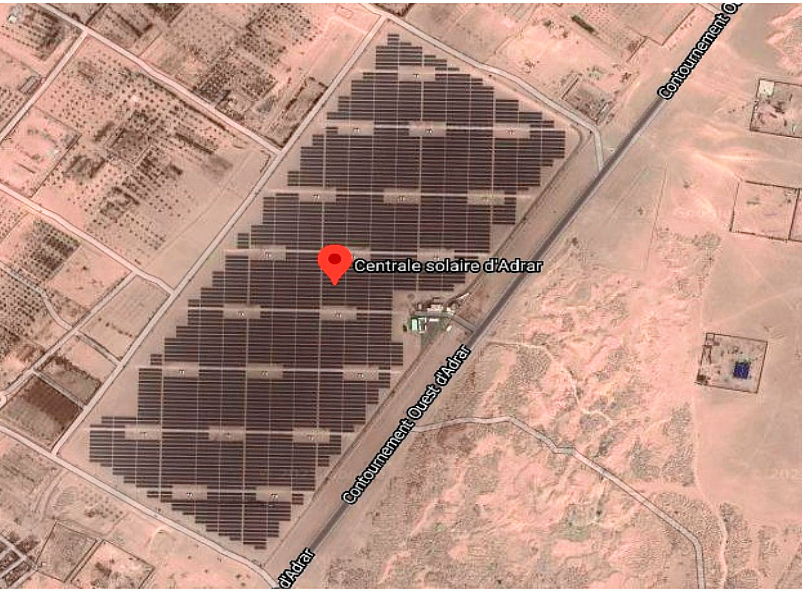
Figure 14. Photovoltaic park of Adrar (Algeria).